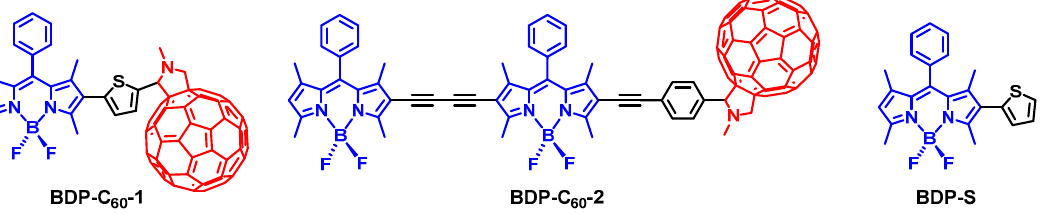
Figure 13. Molecular structures of the antenna-C 60 heavy atom-free triplet PSs, BDP-C 60 -1 and BDP-C 60 -2. BDP-S is a reference compound.